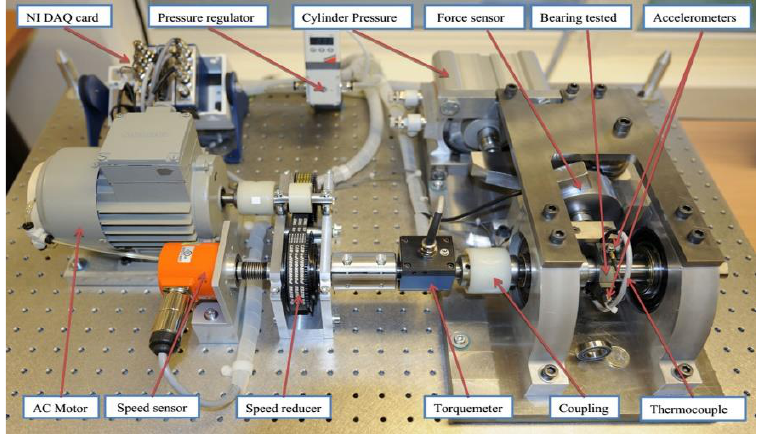
Figure 6. PRONOSTIA experimental platform.